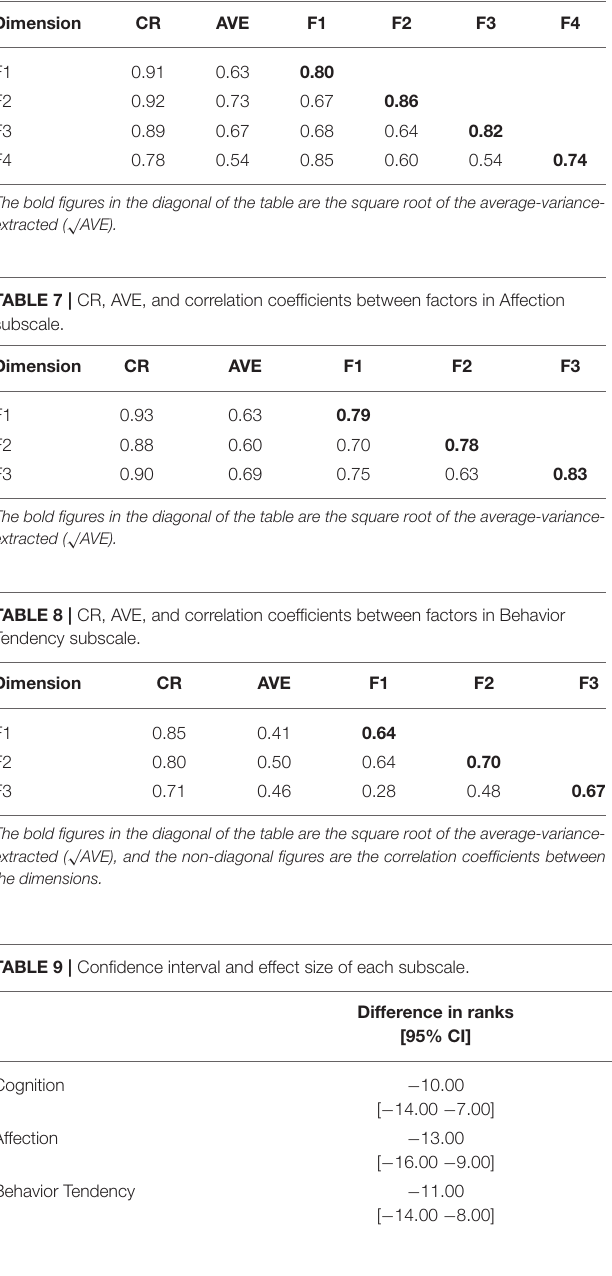
TABLE 6 | CR, AVE, and correlation coefficients between factors in Cognition subscale.